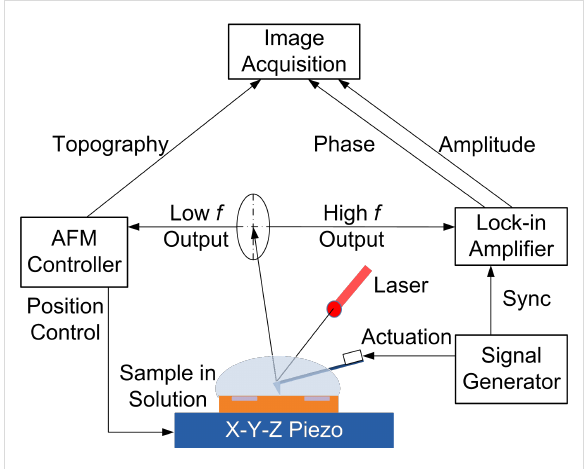
Figure 5: Schematic of the FMM setup. The AFM probe is kept at a constant static contact force when scanning the sample in solution. The signal generator actuates the cantilever probe with a single frequency signal, and the cantilever response is monitored by a lock-in